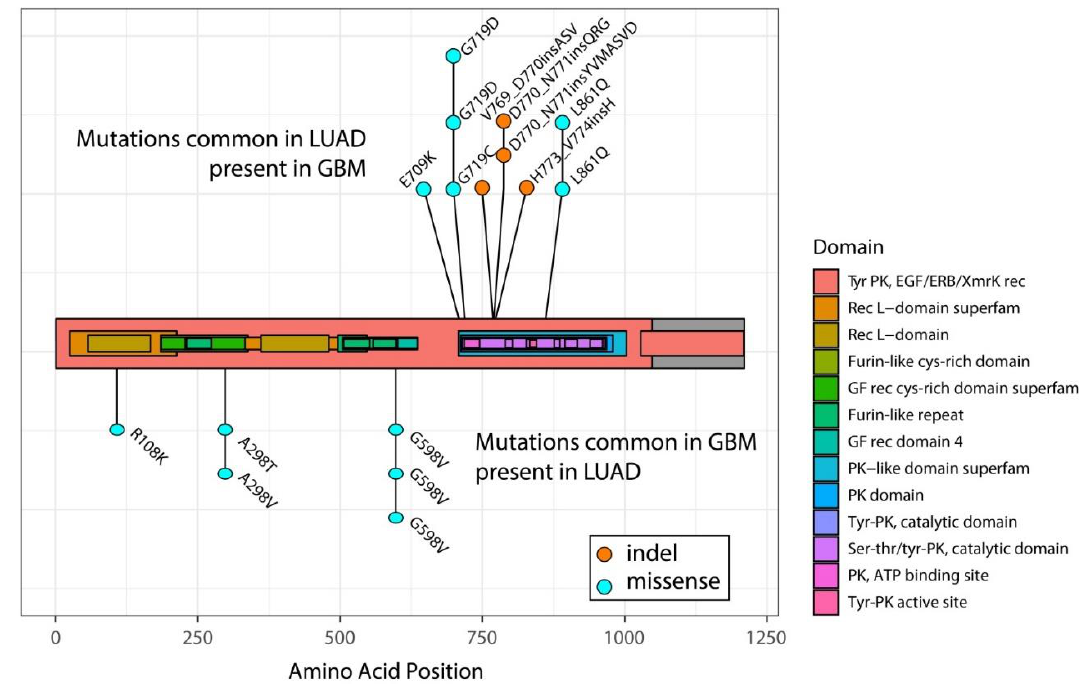
Figure 1. Mutations common to LUAD are sporadically identified in GBMs and vice versa. Each dot reflects a single sample identified with the specific mutation. Domains of EGFR are highlighted in color. PK: protein kinase; GF: growth factor; rec: receptor. The transmembrane is localized around amino acids 622–644.